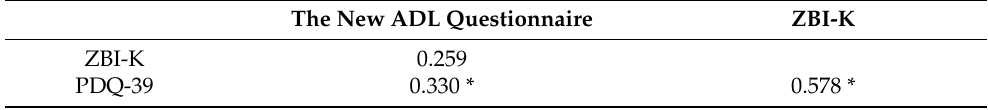
Table 5. Correlation between the dependent variable in the experimental